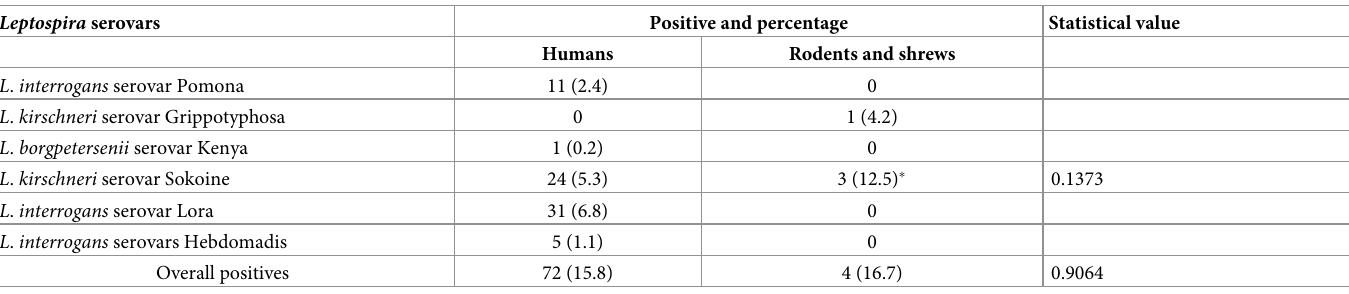
Table 3. Leptospira serovars with antibodies detected in humans (n = 455), rodents and shrews (n = 24). Leptospira